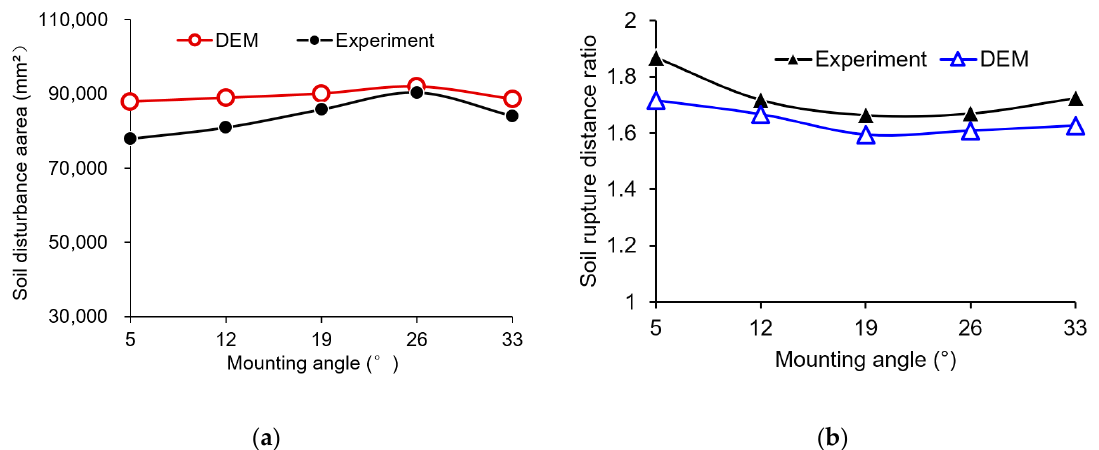
Figure 9. Soil disturbance area ( a ) and soil rupture distance ratio ( b ) as affected by mounting angle.